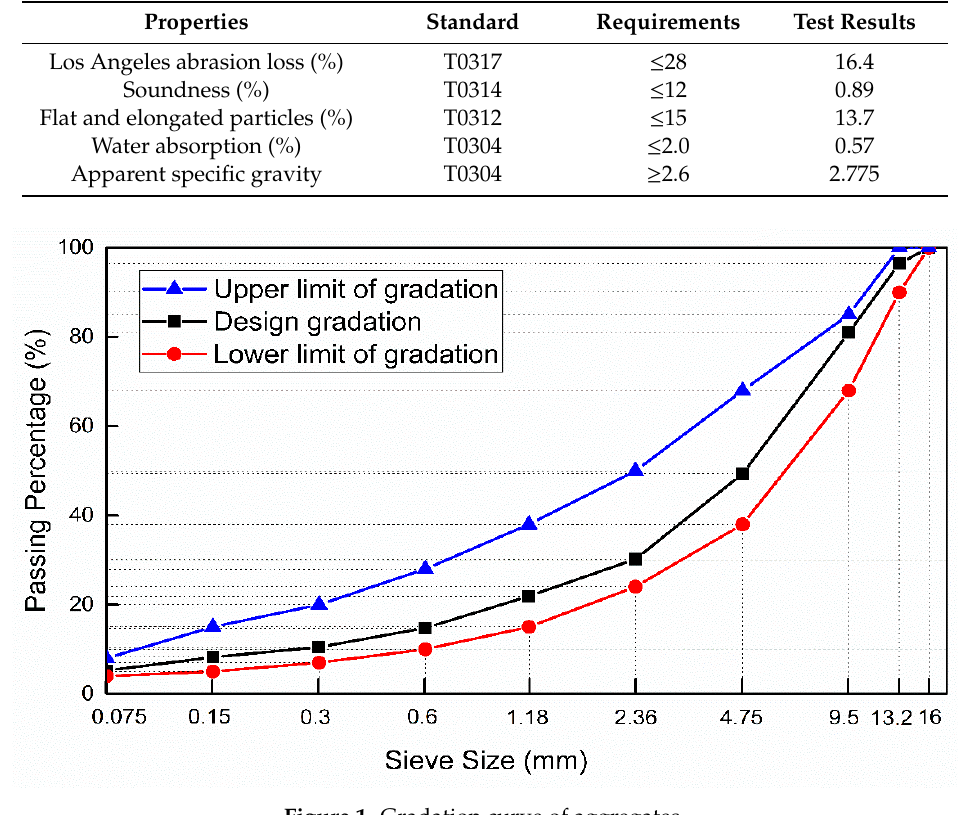
Figure 1. Gradation curve of aggregates.